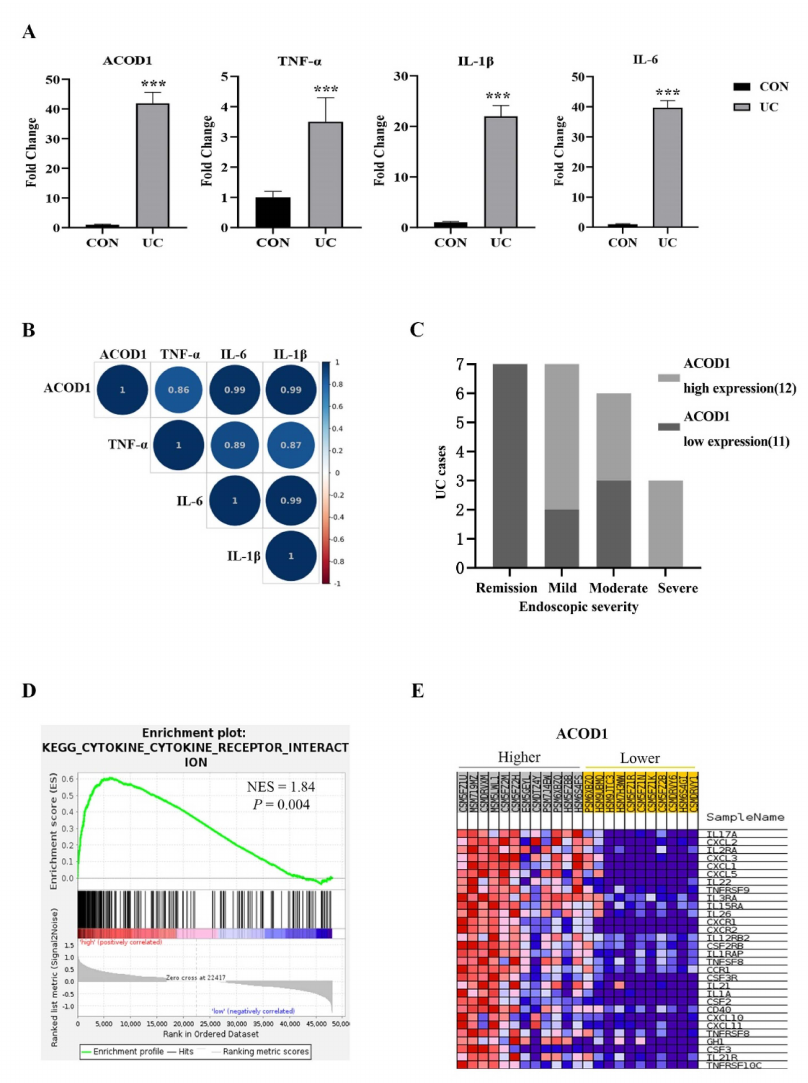
Figure 5. ACOD1 is highly expressed in the colon tissue of UC patients and associated with intestinal inflammation. ( A ) The transcription levels of inflammatory factors (TNF- α , IL-1 β , and IL-6), and